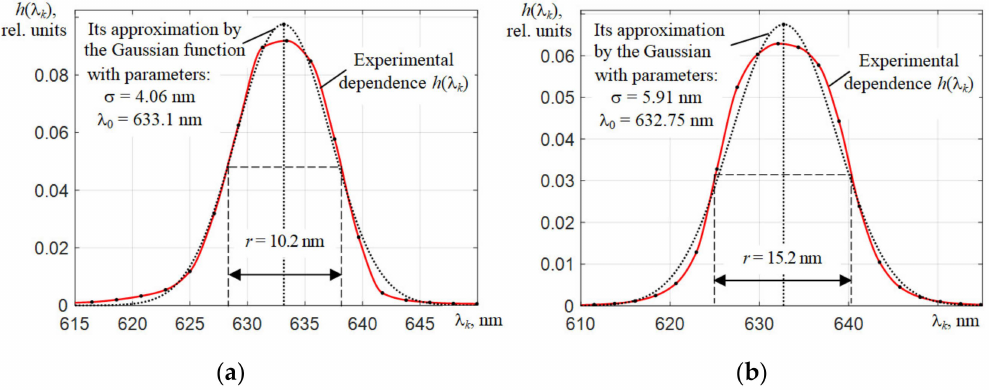
Figure 6. Instrumental functions of spectrometers C12880MA ( a ) and C11708MA ( b ) (solid lines with dots), obtained by illuminating their entrance slits with scattered radiation from a He-Ne laser and their approximation by the Gaussian function (dotted lines) after correcting the shifts of their wavelength λ k count